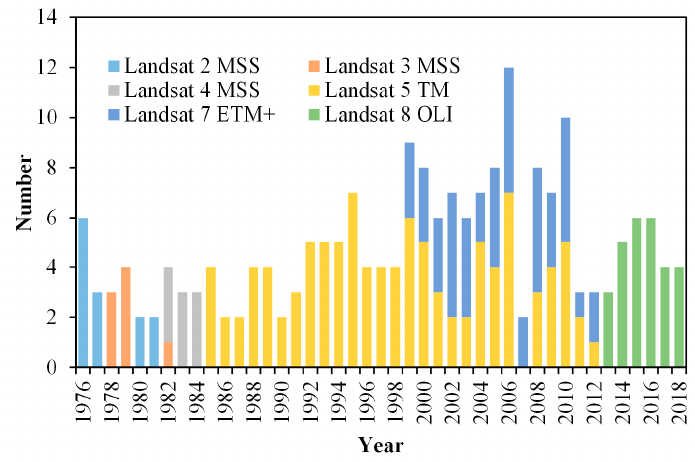
Figure 2. Available numbers of temporal Landsat time series images used in this study.